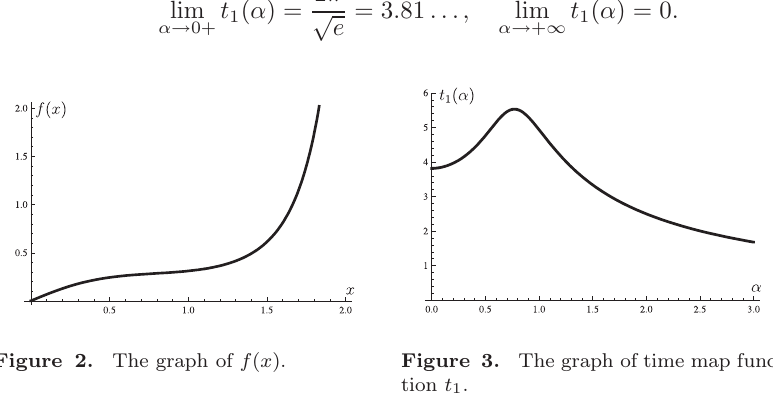
Figure 2. The graph of f ( x ) . Figure 3. The graph of time map func- tion t 1 .